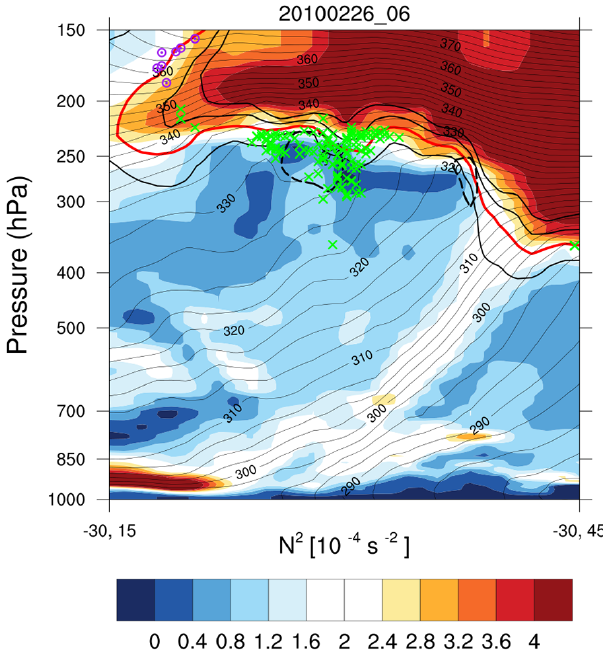
Figure 3. Vertical cross-section along 30 ◦ W from 15 to 45 ◦ N (white line in Fig. 2) at 06:00UTC 26 February 2010. The Brunt–Väisälä frequency N 2 is shown with coloured contours (in 10 − 4 s − 2 ), the thin black lines show isentropes (in K) and the thick contours are isosurfaces of PV (1–4pvu, 2pvu red, rest black). STT and TST events occurring in a symmetric 6h time window and within ± 5 ◦ longitude are shown with green crosses and purple dot- ted circles, respectively.